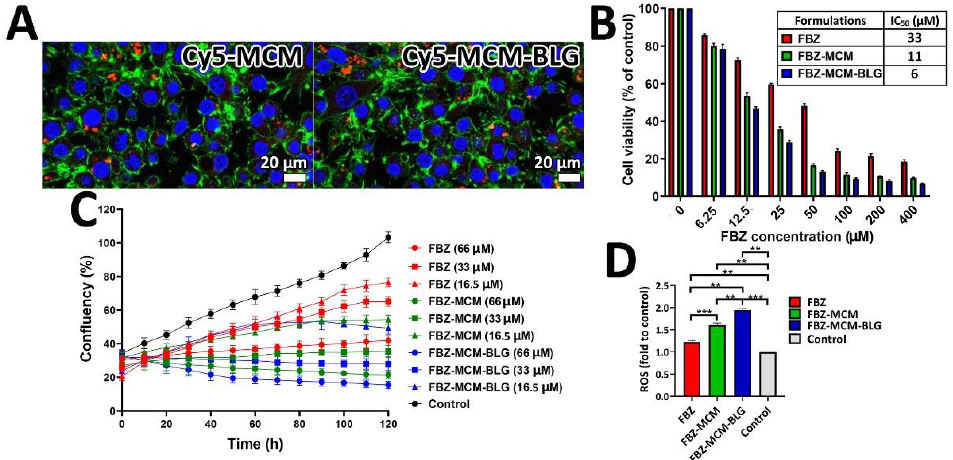
Figure 6. ( A ) Cellular uptake images of PC-3 cells after 4 h incubation with Cy5-MCM and Cy5- MCM-BLG nanoparticles. As the images show, higher fluorescence intensity was observed in the cells incubated with MCM-BLG nanoparticles. ( B ) Viability effects of FBZ-MCM and FBZ-MCM-BLG nanoparticles compared to FBZ on prostate cancer PC-3 cells after 48 h incubation. The data are expressed as mean ± SD ( n = 3). ( C ) Cell proliferation effects of FBZ, FBZ-MCM, and FBZ-MCM-BLG nanoparticles on PC-3 cells over 5 days. ( D ) ROS generation in PC-3 cells after 6 h incubation with FBZ, FBZ-MCM, and FBZ-MCM-BLG nanoparticles. The results are expressed as mean ± SD from three independent experiments and were analyzed using a t-test: ** p < 0.01, *** p < 0.001.